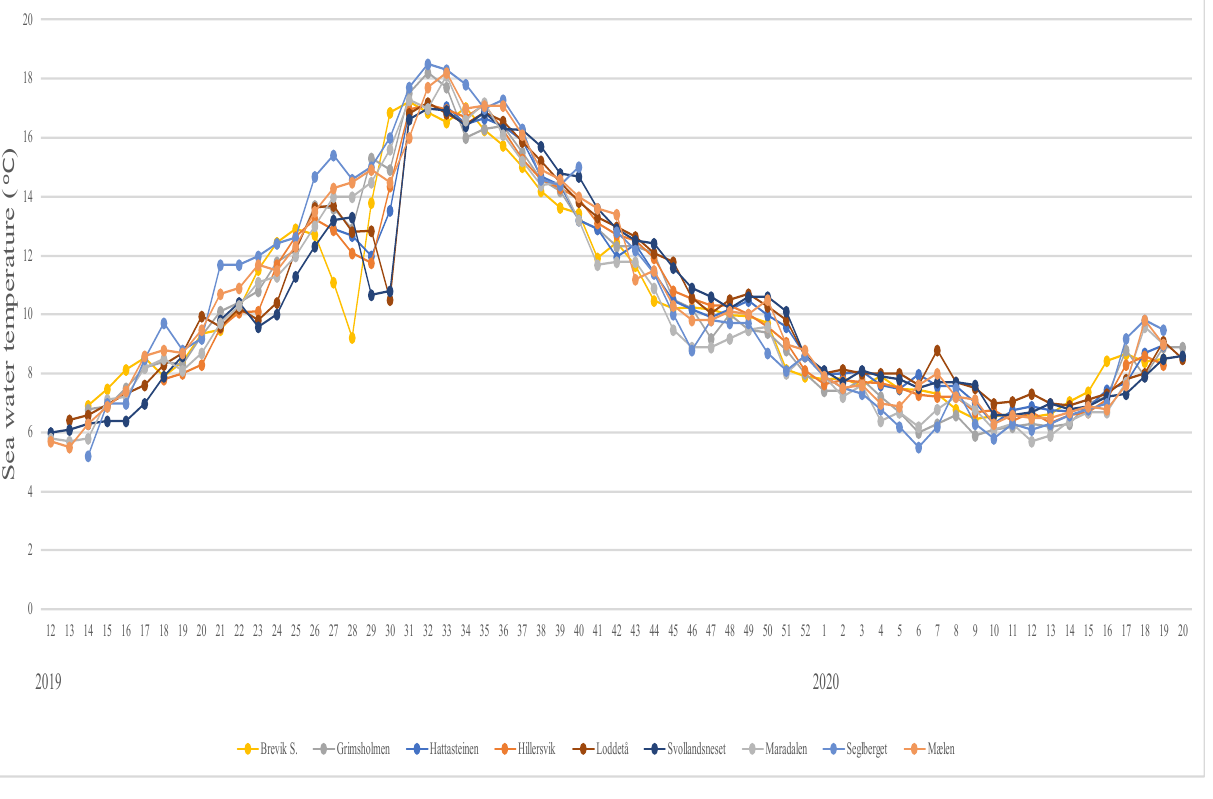
Figure 3. The sea temperature at all the facilities in experiment 2 from week 12 in 2019 until week 20 in 2020 located in Hardangerfjorden, measured at approximately a 6–9-m